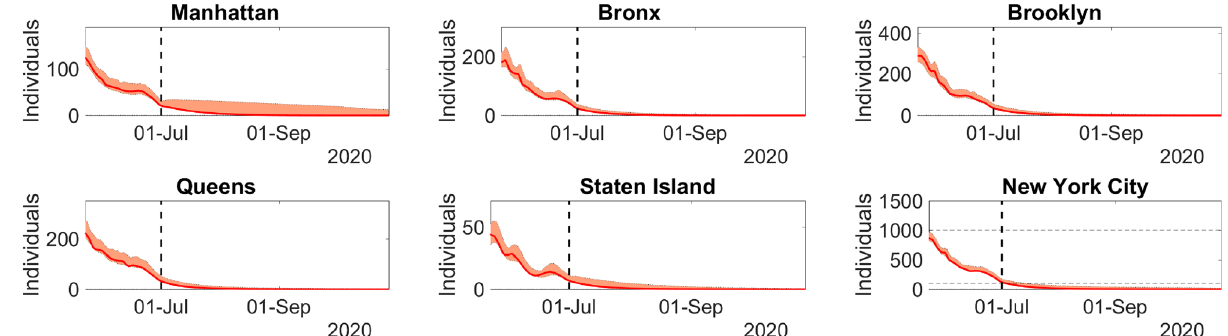
Figure 6. Model predictions of daily new infections for the period 02-July-2020 to 29-Oct-2020 in NYC, when lockdown is slightly lifted, but keeping strict containment measures. The filled envelopes represent the 90% CIs. Figure generated with MATLAB R2019b (mathworks.com).